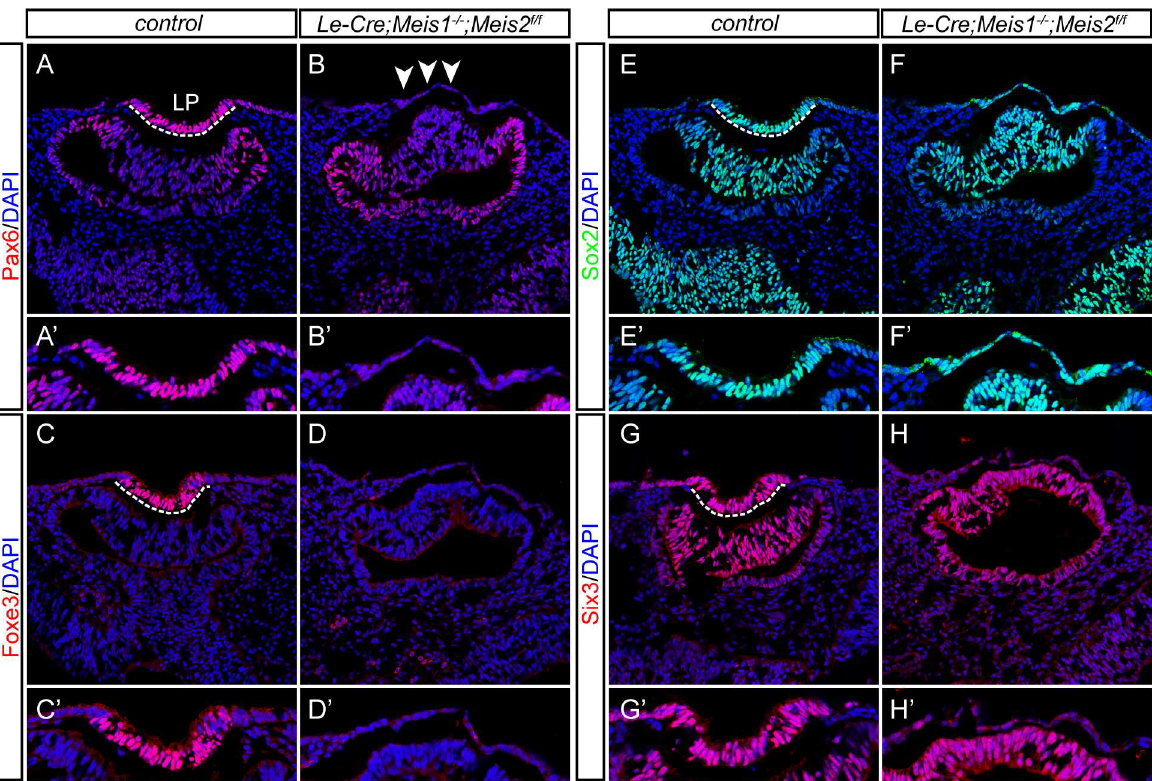
Fig 2. The expression of lens placode-specific transcription factors is disturbed in Meis1/Meis2 double mutants. ( A-H‘ ) Cryosections from E10.0 control and Le-Cre;Meis1 -/- ;Meis2 f/f embryosstained with antibody as indicatedand nucleicounterstained with DAPI. ( B, B‘ ) Pax6 is not detected in lens surface ectoderm of Le-Cre;Meis1 -/- ;Meis2 f/f embryos (arrowheads) and ( D, D‘ ) expressionof the lens differentiationgene Foxe3 is not initiated. ( F, F‘ ) Sox2 is detected in PLE of Meis1/Meis2 doublemutants, althouth it failed to thicken. ( H, H‘ ) Finally, expressionof Six3 is decreased comparedto control. Lens placode(LP) is indicatedby dashedline. ( A‘-H‘ ) For clearer examination, lens placodeor corresponding lens surface ectoderm regionis magnifiedand shown